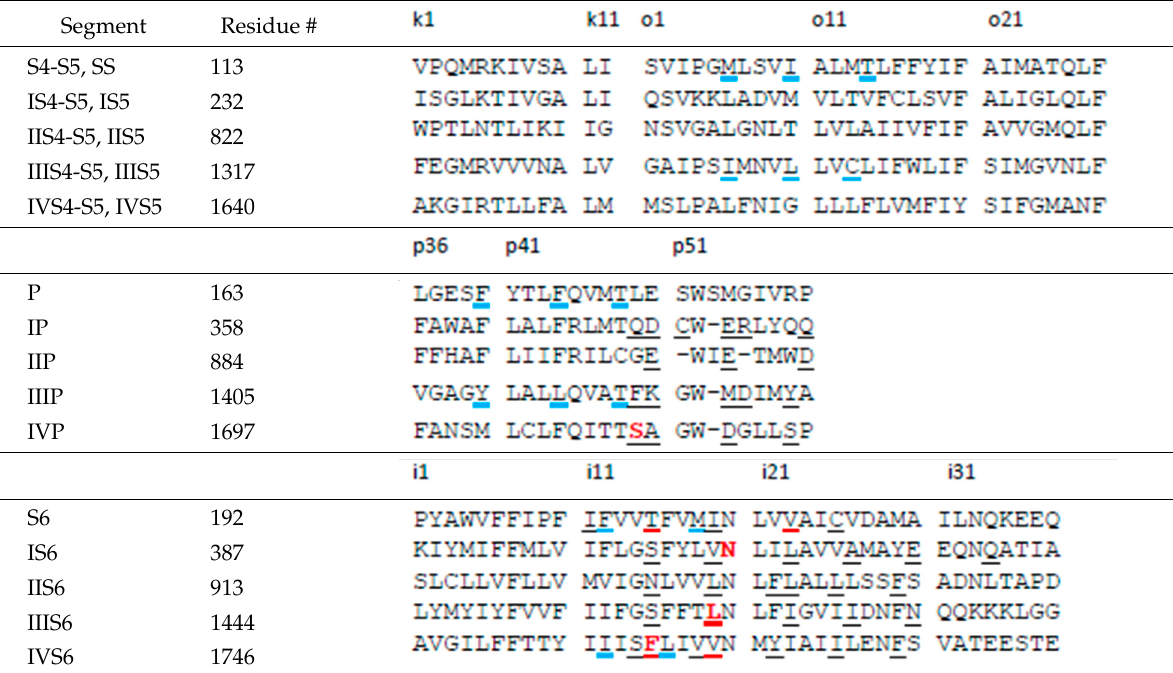
Table 1. Sequences of transmembrane helices and P-loops in the pore domain of NavAb